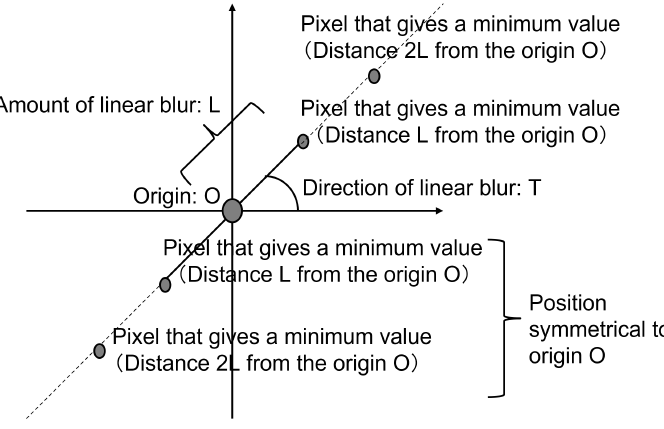
Figure 1. Schematic diagram of a cepstrum caused by linear blurring. The following three points were confirmed, assuming an actual bridge